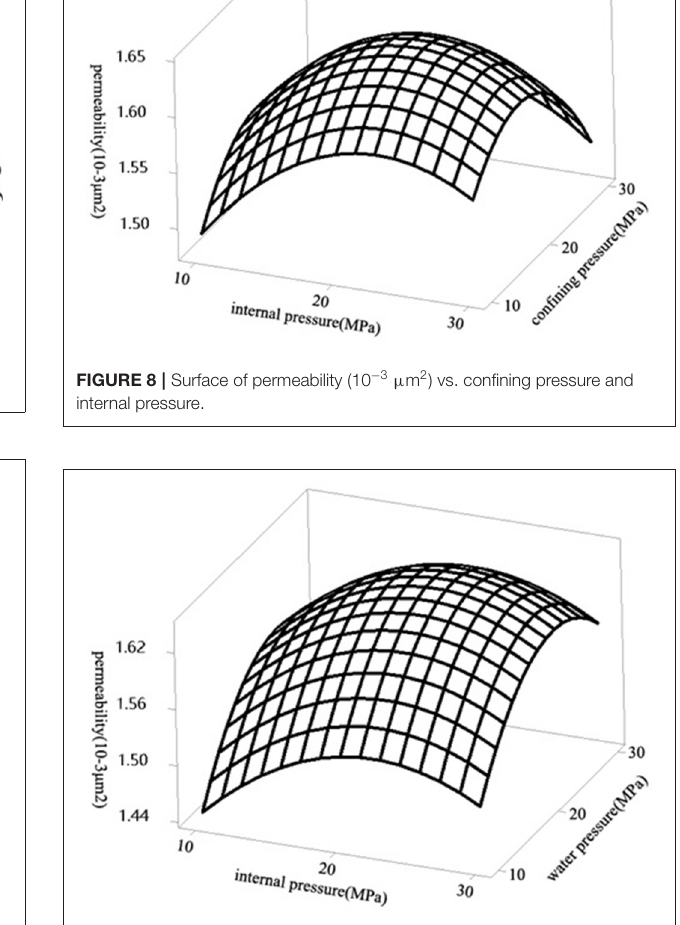
FIGURE 9 | Surface of permeability (10 − 3 µ m 2 ) vs. water pressure and internal